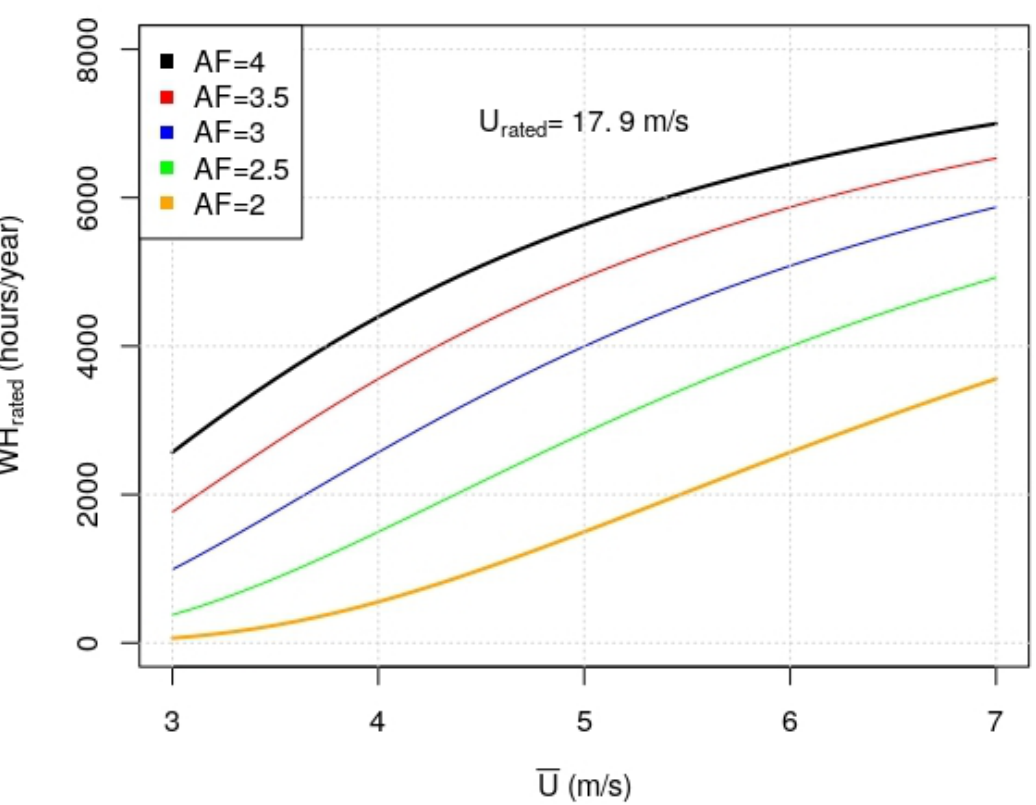
Figure 13. Annual working hours at rated power versus U for different AF